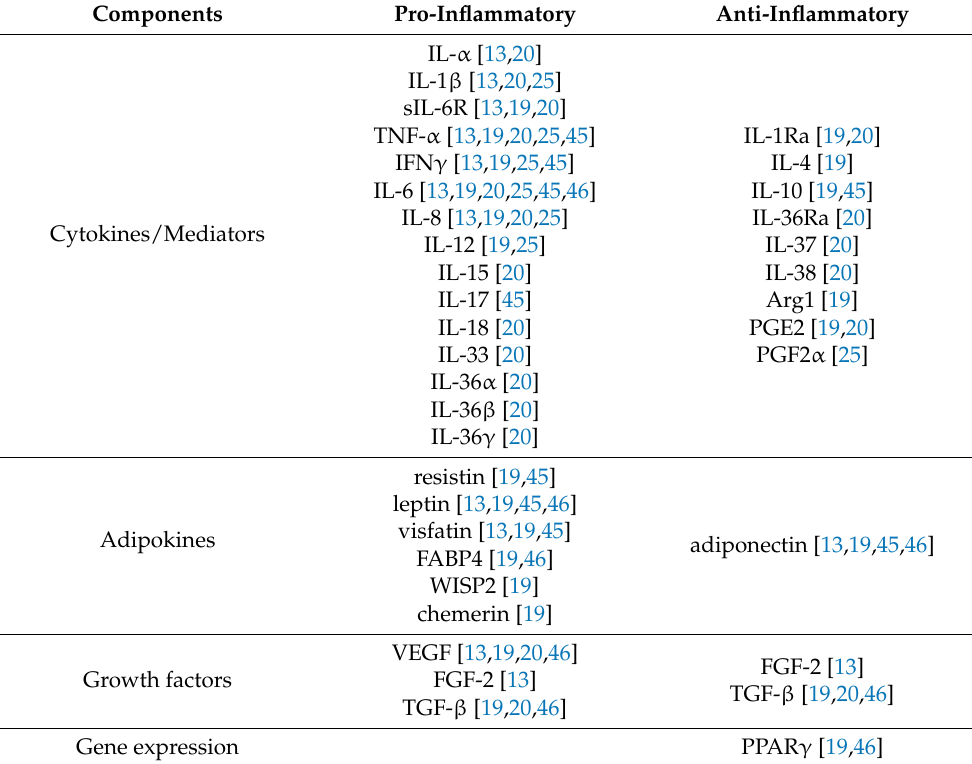
Table 2. Expression of inflammatory factors and presence of mononuclear cells in the human IFP during OA pathogenesis and